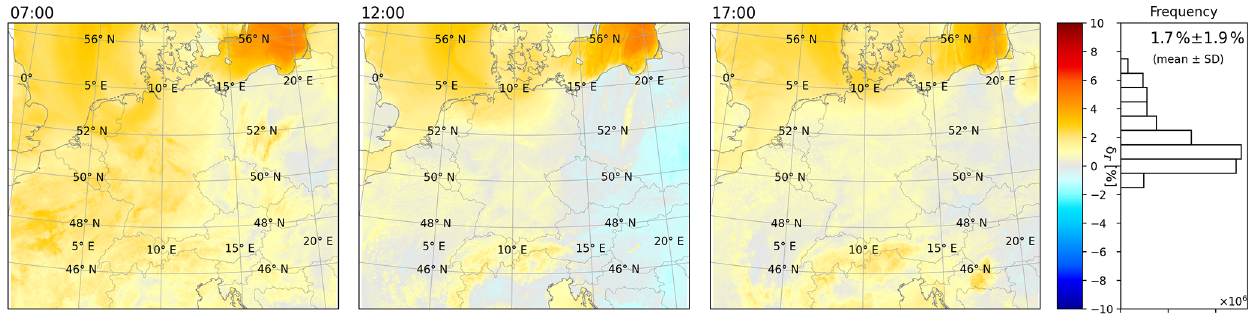
Figure 2. Deviation δ (cid:48) according to Eq. (19) for WRF simulations at 07:00, 12:00, and 17:00UTC on 1 May 2018. On the right, the frequency distribution of δ (cid:48) and its mean and SD are given for the WRF simulation period from May to June 2018.